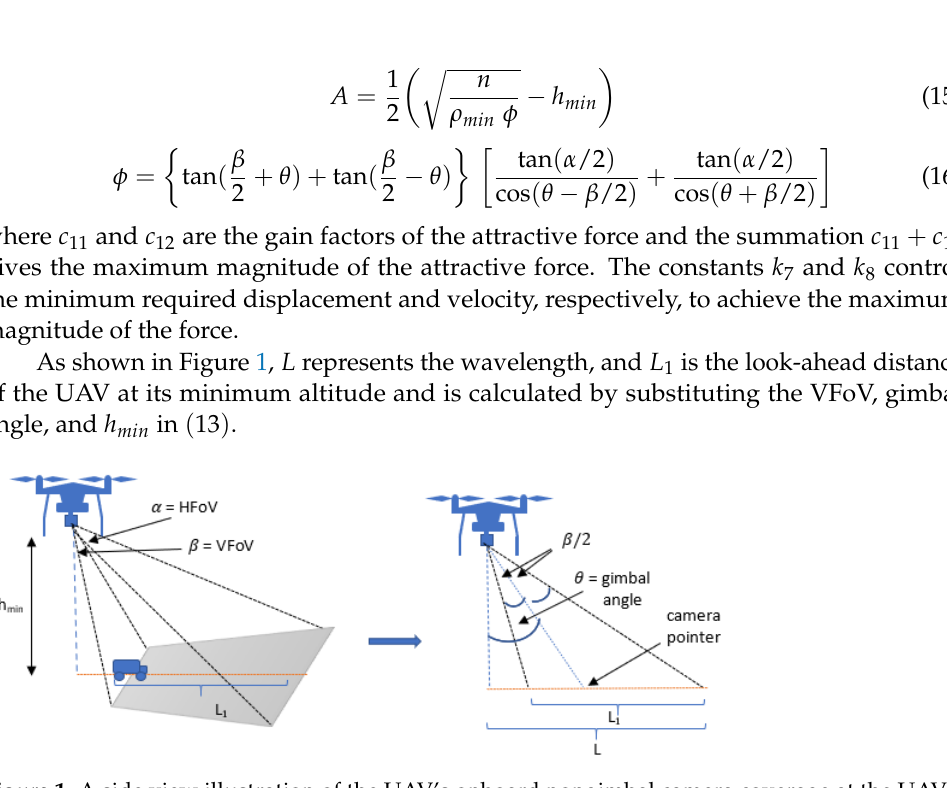
Figure 1. A side view illustration of the UAV’s onboard nongimbal camera coverage at the UAV’s minimum flying